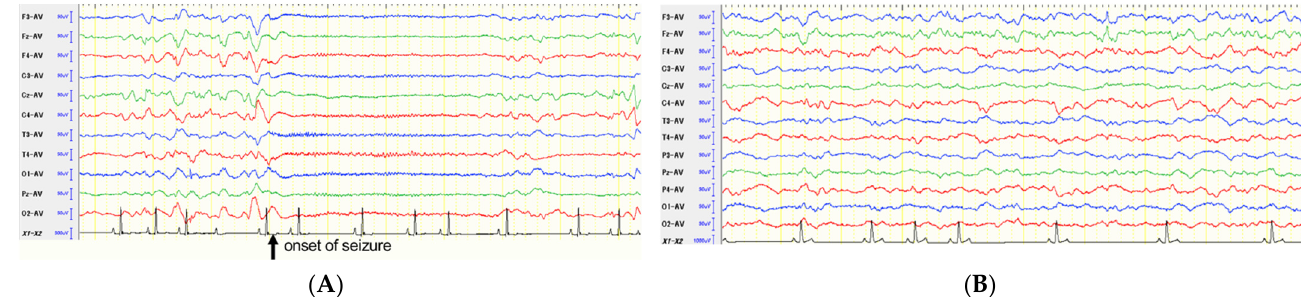
Figure 3. Scalp EEGs before ( A ) and at 12 months after ( B ) total CC in Case 2. Preoperatively, the large sharp wave and following low amplitude and fast rhythmic activities with clinical facial myoclonic seizures (arrow) were observed frequently, other than the common interictal epileptiform discharges during the EEG recording ( A ). On the postoperative EEG, those seizure activities were not observed, and common spikes or sharp waves were sporadically observed ( B ).